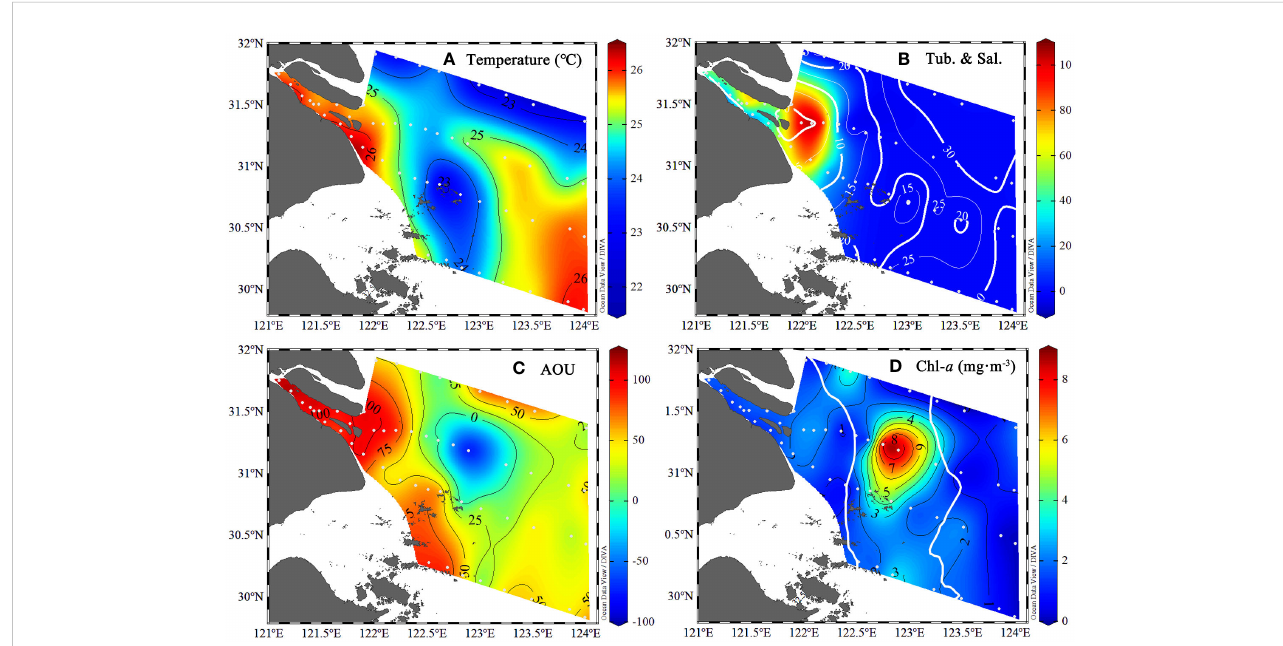
FIGURE 2 The environmental parameters from the surface water (~3 m) of the Changjiang River Estuary in the summer. (A) water temperature (°C); (B) water turbidity (NTU) with overlaid salinity (solid white line); (C) The derived Apparent Oxygen Utilization (AOU, m mol/kg); (D) The chlorophyll- a concentration ( m g/m 3 ) with the location of the sediment and plume fronts (solid white